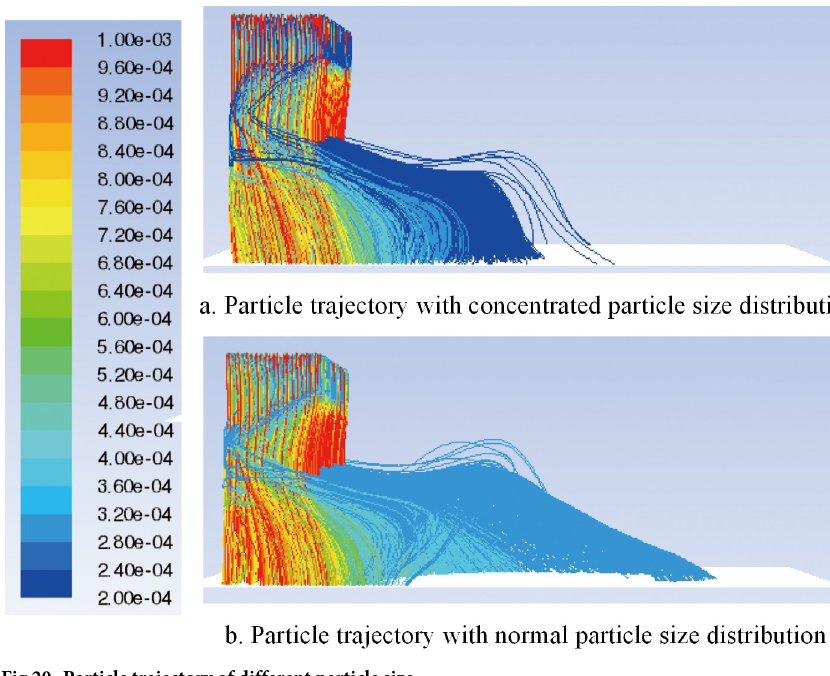
coarse particles of different particle sizes on the front deposition, thereby improving the uni- formity of particle deposition on the bottom surface. Simulation of the airflow forming machine with shaving particles. The characteristic lines are selected at the same position as the original model in the model with shaving particles, as shown in Fig 21 (Line-1 in the original model corresponds to the particle model Line-1 � , and the other characteristic lines have the same correspondence relation).